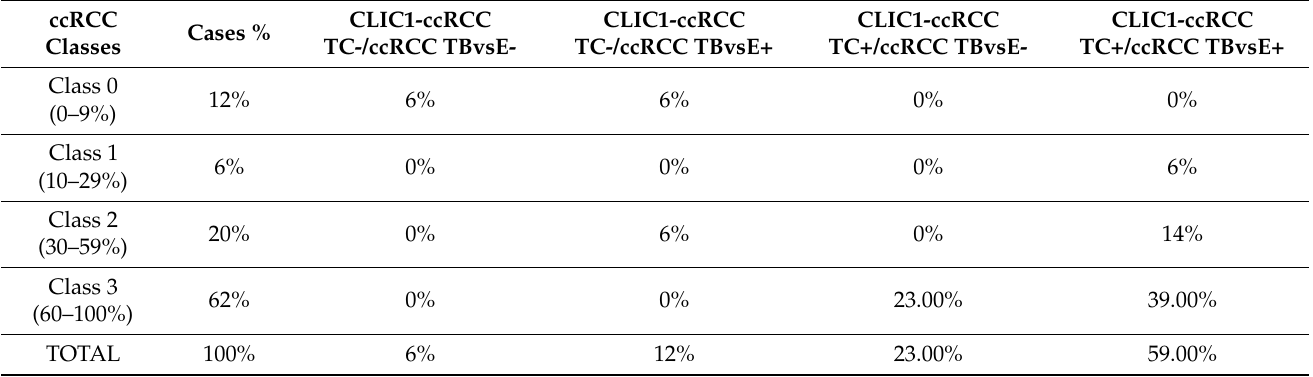
Table 2. ccRCC cases classified in 4 groups according to the percent of positive tumor cells and their subgroups stratification based on CLIC1 expression in the tumor blood vessel